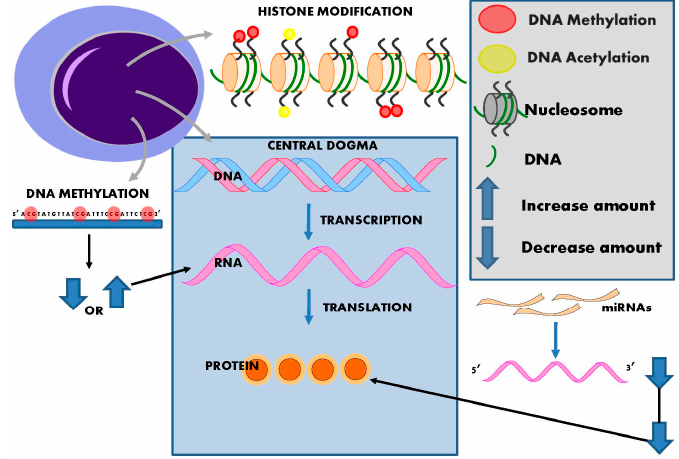
Figure 5. Impact of epigenetic modifications. DNA wrapped around nucleosomes are made up of four pairs of histone proteins. Histone proteins are prone to epigenetic modification, primarily acetylation and methylation but also phosphorylation, sumolyation, and biotinylation. These modifications change the formation of chromatin to either an open (active) or closed (inactive) state, thereby altering their transcriptional activity. DNA methylation changes the structure of DNA itself, allowing active transcription or silencing of genes. The outcome of DNA methylation is dependent on the location of the methylated site. miRNAs primarily target the 3’ UTR of mRNA (although 5’ targeting is possible). This negatively regulates the quantity of the encoded protein produced via degradation of mRNA molecules or by post-transcriptional regulation of mRNA